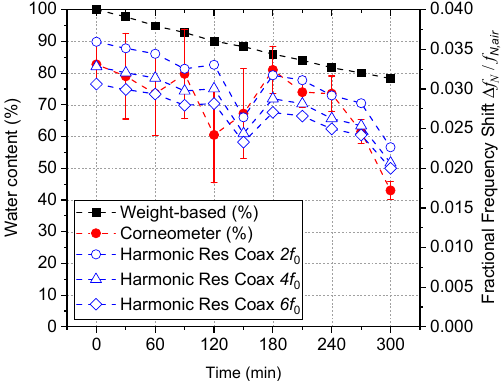
Figure 9. Water content over time of the cervix sample A (03215) measured by Corneometer (left Y -axis) and the harmonic resonance coaxial probe (right Y -axis) with relative weight-based water content (left Y -axis).